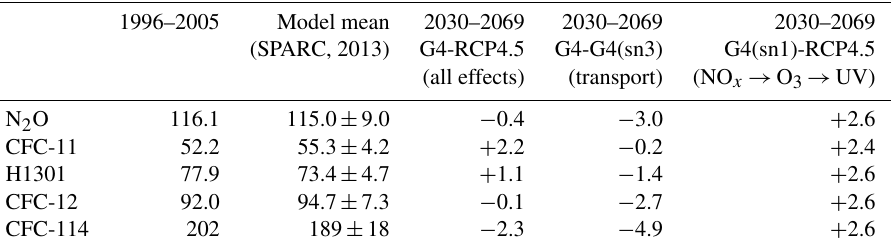
Figure 5. Zonal mean mixing ratio anomalies G4-RCP4.5 for (a, b) GEOSCCM and (c, d) ULAQ-CCM, CH 4 (a, c) and N 2 O (b, d) (time average 2040–2049). ULAQ-CCM results are for case (a) in Table 1. Units are ppbv. In panels (a, c) , the contour line increment is 10; in panels (b, d) , the contour line increment is 2. Table 4. Atmospheric lifetimes (years) calculated in the ULAQ-CCM (case b in Table 1), relative to five species with stratospheric photolysis and O( 1 D) reaction sink (i.e., N 2 O, CFC-11, H1301, CFC-12, CFC-114). The first column shows year 2000 values (as an average over the 1996–2005 decade); the second column shows a model mean from the SPARC (2013) report on lifetimes. Subsequent columns show the calculated lifetime anomalies due to sulfate geoengineering (average 2030–2069). Inside the square brackets we highlight the physical and chemical effects driving the lifetime changes: changing stratospheric transport in the fourth column and changing stratospheric O 3 in the fifth column (due to the aerosol-induced NO x loss). Results in the rightmost two columns are obtained through G4 sensitivity experiments (sn1, sn3) explained in Table